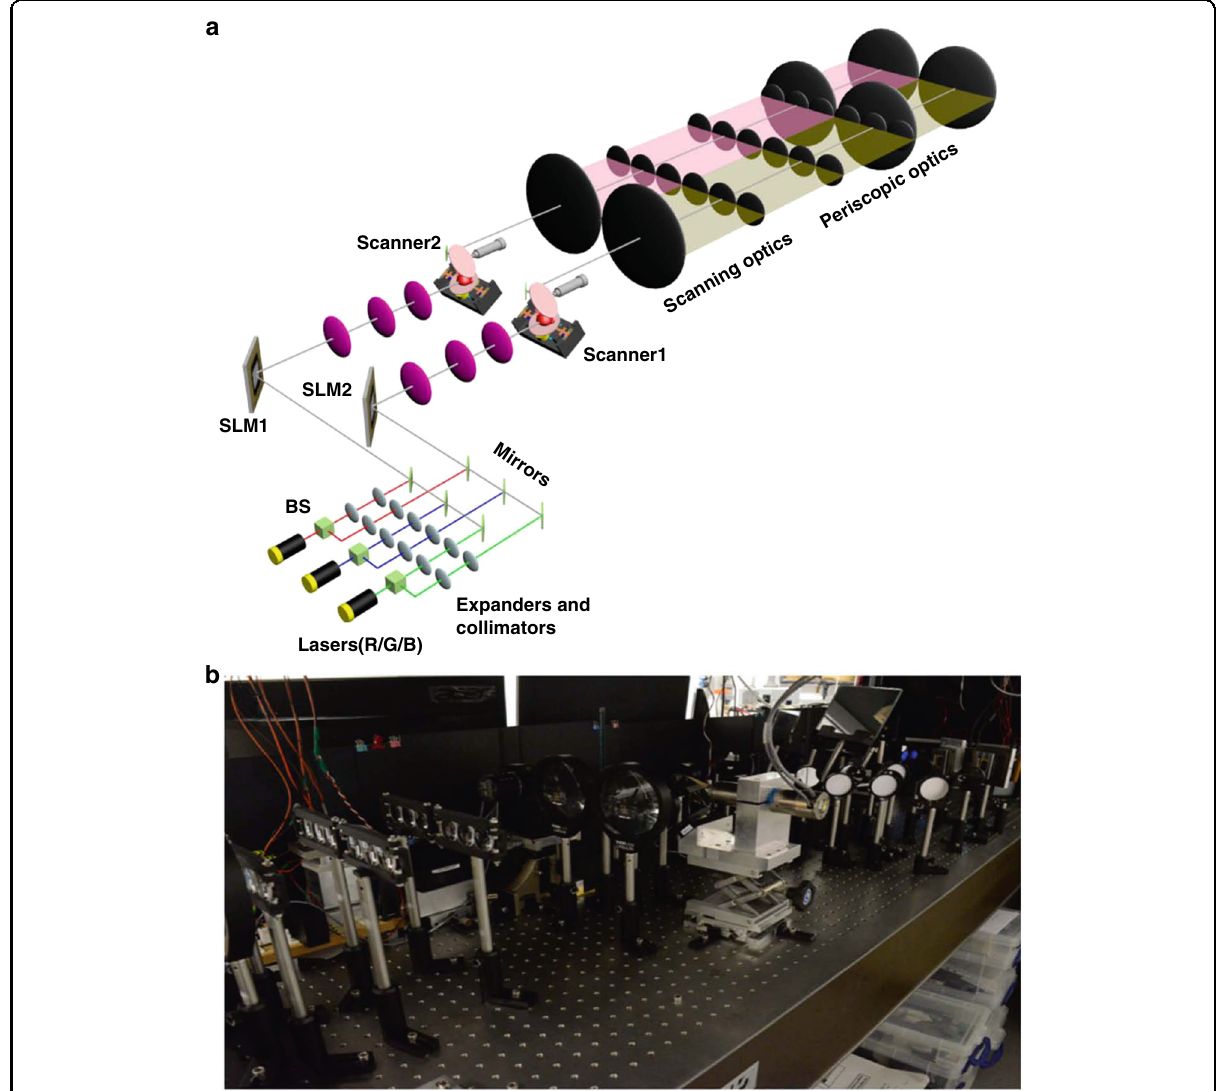
Fig. 4 A proof-of-concept system of two holobricks. a The schematic setup, and b the experimental